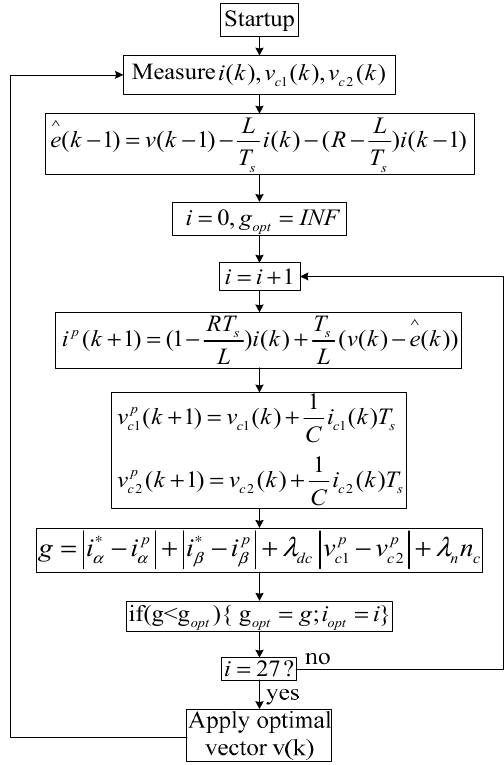
Figure 10. The cost function flow chart of the T-type inverter model prediction control algorithm.